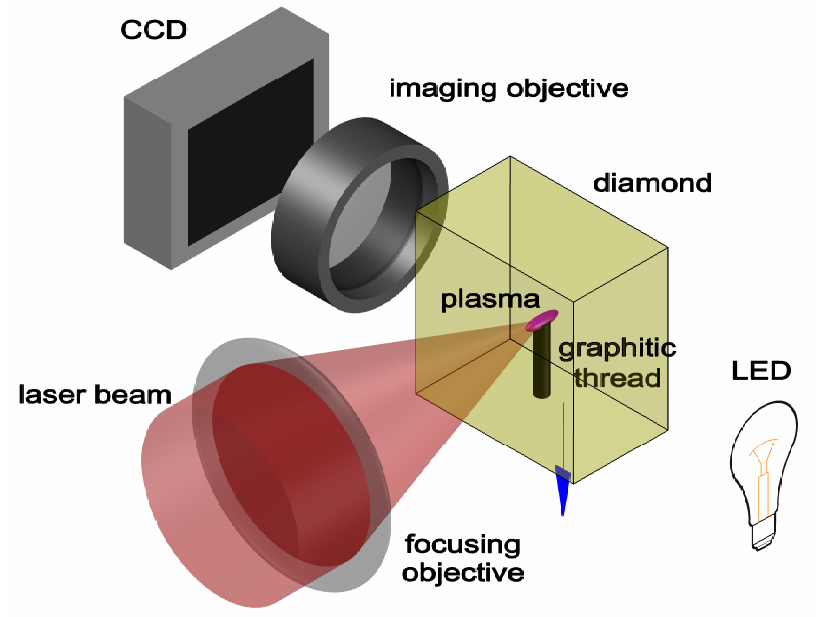
Figure 2. The experimental setup for diamond processing. Blue arrow points out the direction of sample